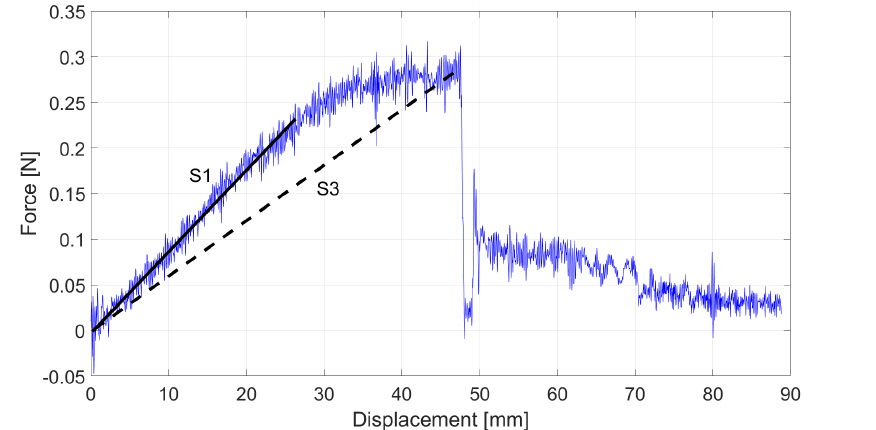
Figure 3. Force-displacement signal of a flexural strength measurement with conventional model ice (S1000). The slope S1 marks the initial linear deformation behavior and S3 the representative average linear deformation behavior.